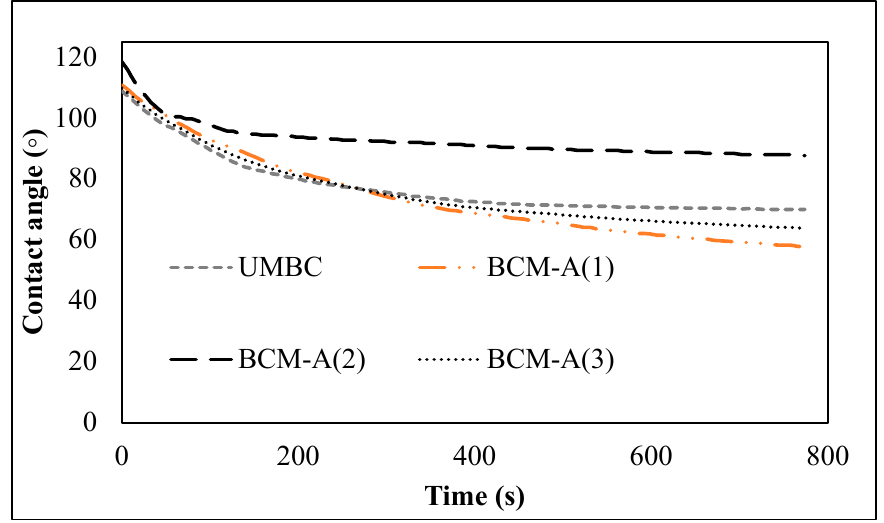
Figure 2. Contact angles of the modified and unmodified biocokes.